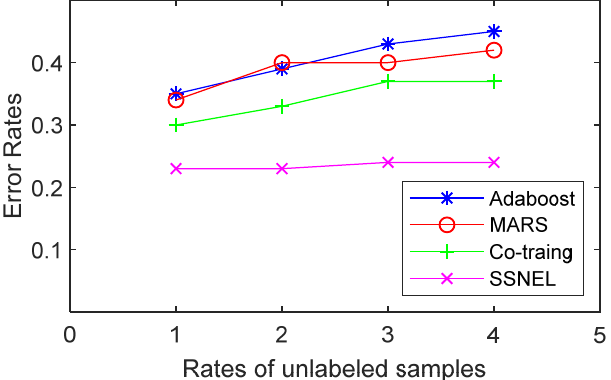
Figure 4. Error rates of the compared methods (wine).